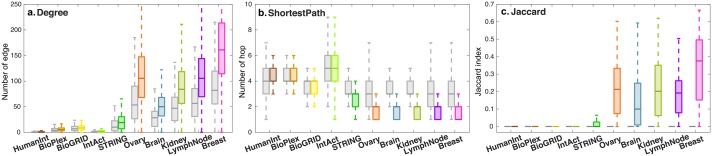
Comparison of three topological measures calculated over biological networks a. degree, b. shortest path and c. Jaccard index.Each color represents a network. Gray boxes represent the same topological measures calculated on the shuffled network.